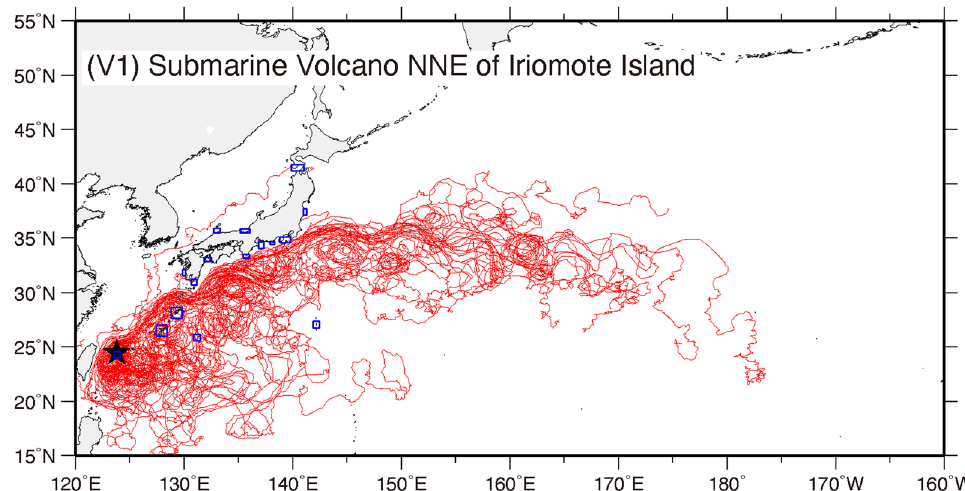
Fig. 4 Simulated drift paths of 50 randomly selected virtual pumice clasts released from V1 (the submarine volcano NNE of Iriomote Island, indicated by the black star) on 15 March 2004. Blue rectangles indicate target